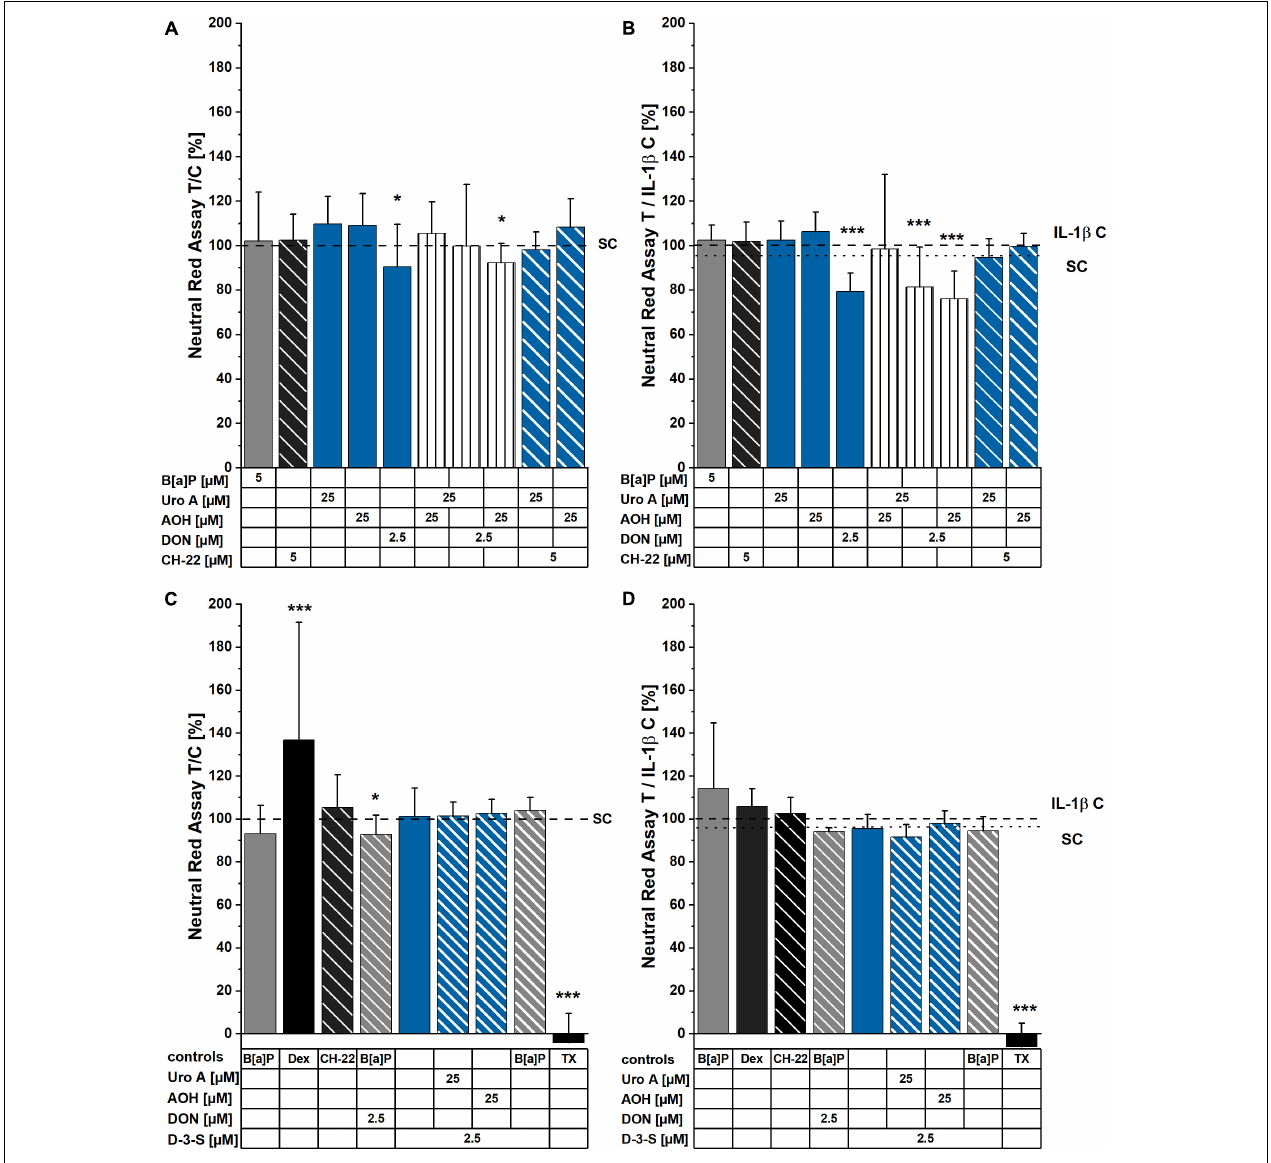
FIGURE 3 | Neutral Red (NR) assay after 48 h of incubation. Cells were either exposed to compounds for 48 h (A,C) , or stimulated with IL-1 β , 2 h into substance incubation (B,D) . Differences in incubation conditions shown in (A,B) compared to (C,D) concern B[a]P: 5 µ M (A,B) and 1 µ M (C,D) . Dexamethasone (Dex) was applied at 5 µ M (C,D) . Lysosomal activity measurements are normalized to solvent control or IL-1 β control, respectively. For significant differences compared to control, two-sample Students’ t- test was applied and is marked by asterisks: * p < 0.05, *** p <